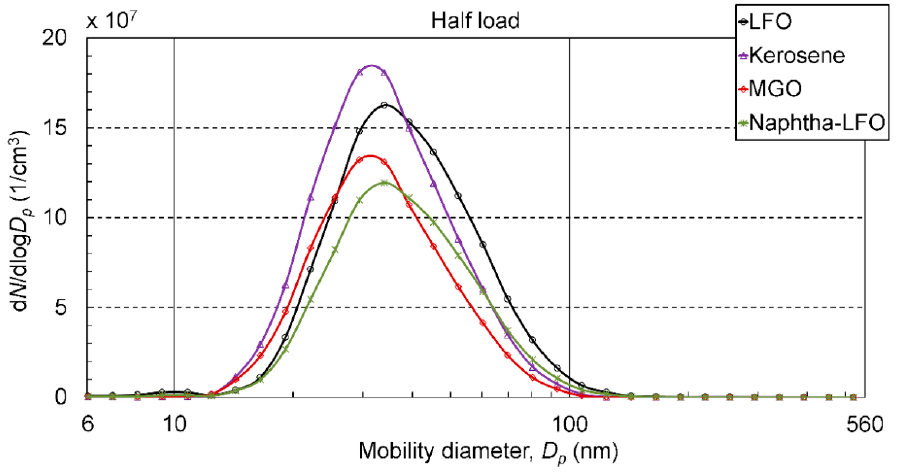
Figure 4. Exhaust PSDs at half load.